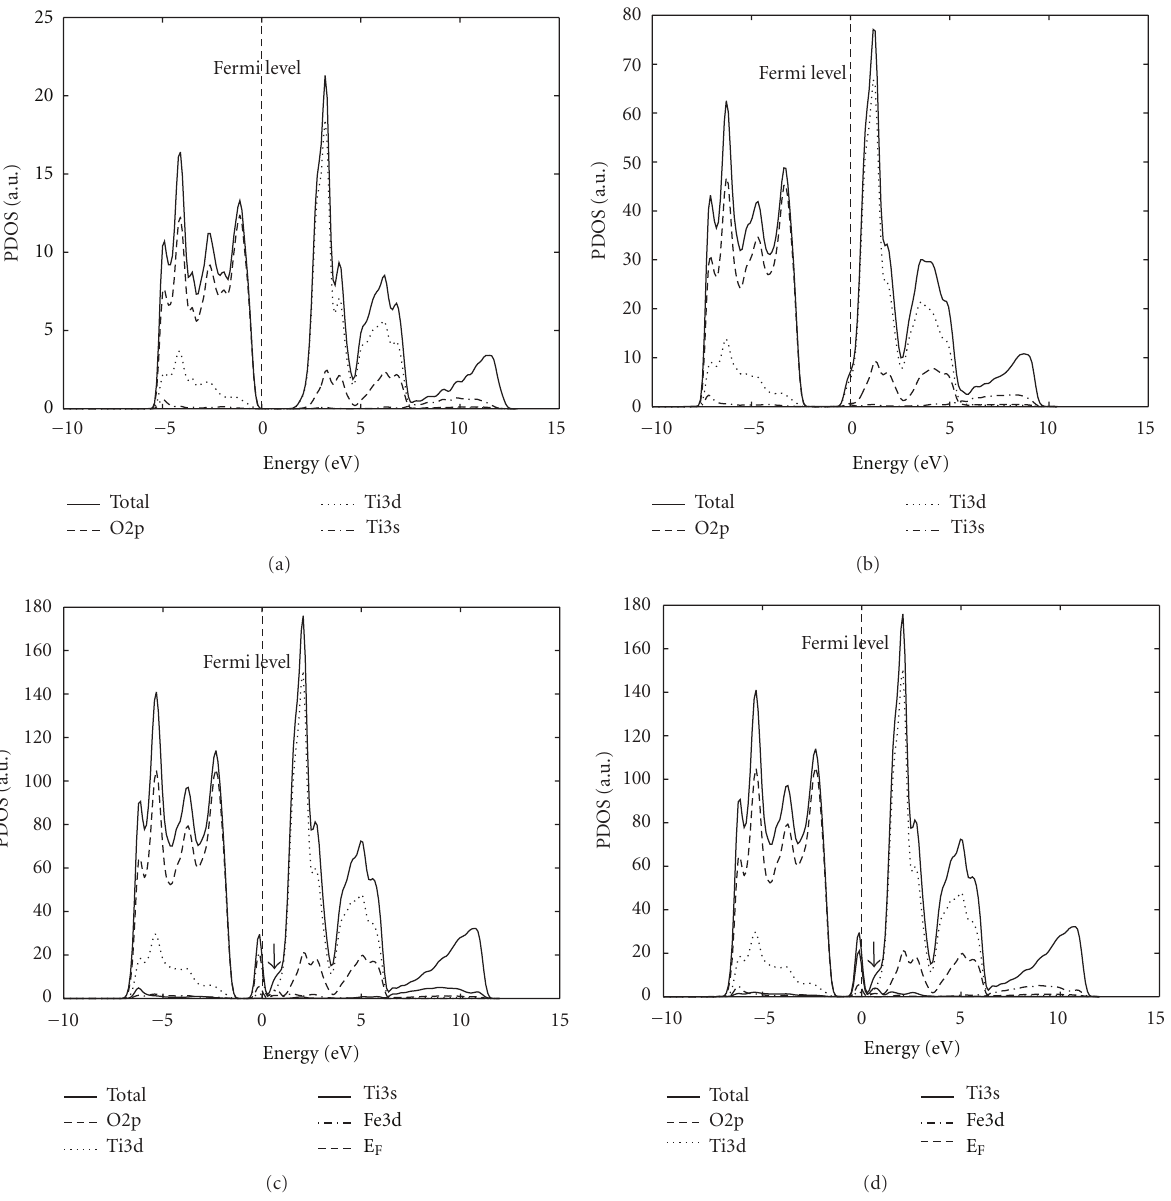
Figure 6: The PDOS of pure TiO 2 (a), 48 atom supercell containing one oxygen defect (b), 48 atom supercell containing a Fe ion (c), and 108 atom supercell containing two adjacent Fe ions and oxygen defect